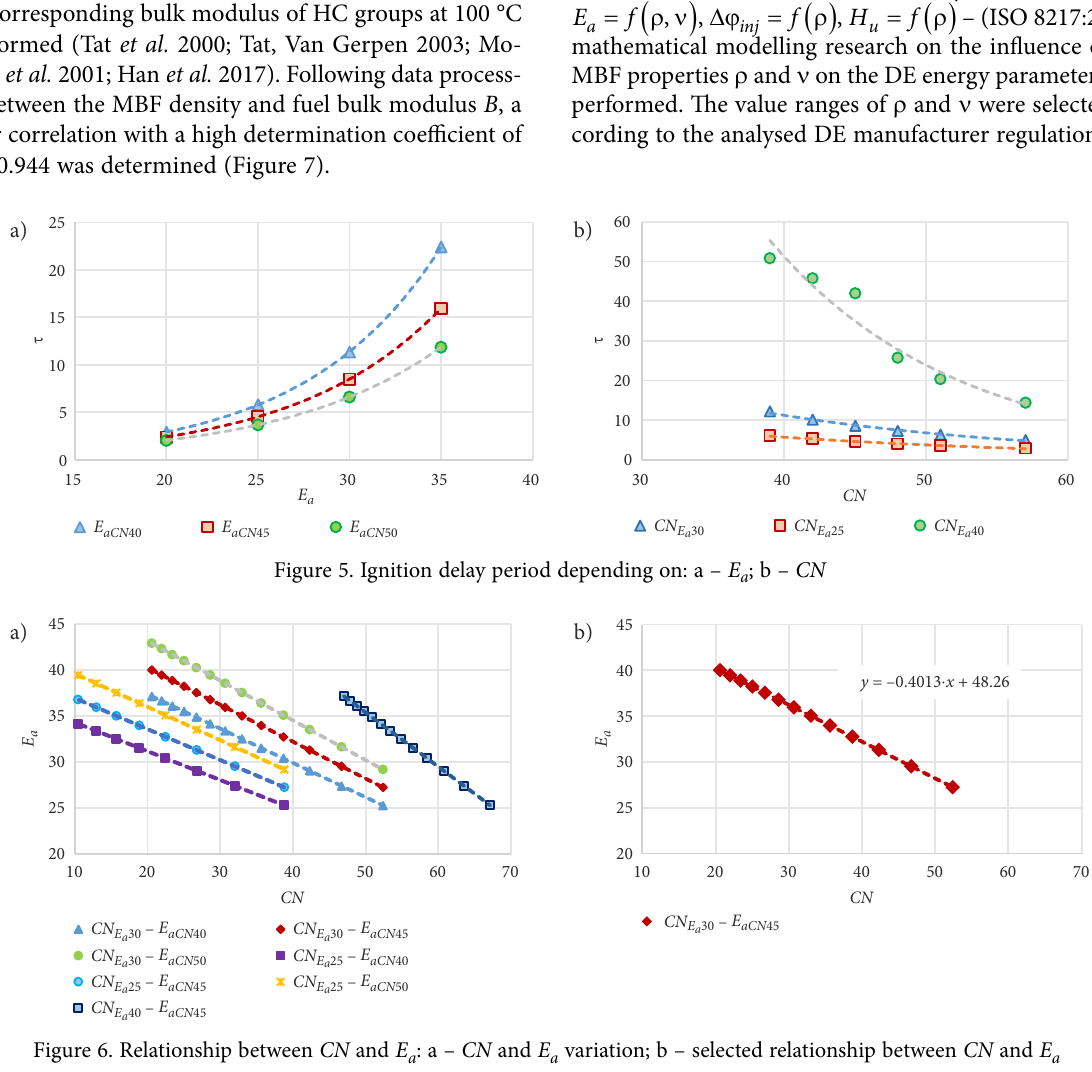
Figure 6. Relationship between CN and E a : a – CN and E a variation; b – selected relationship between CN and E